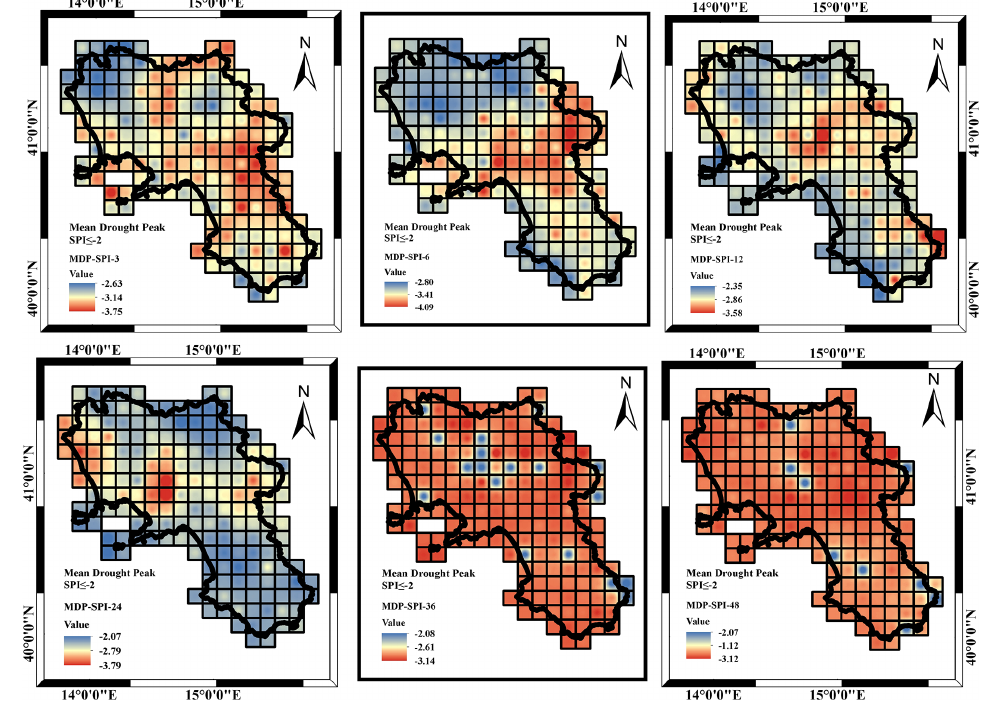
Figure 13. MDP (mean drought peak) for the different accumulation periods considered (SPI ≤ −